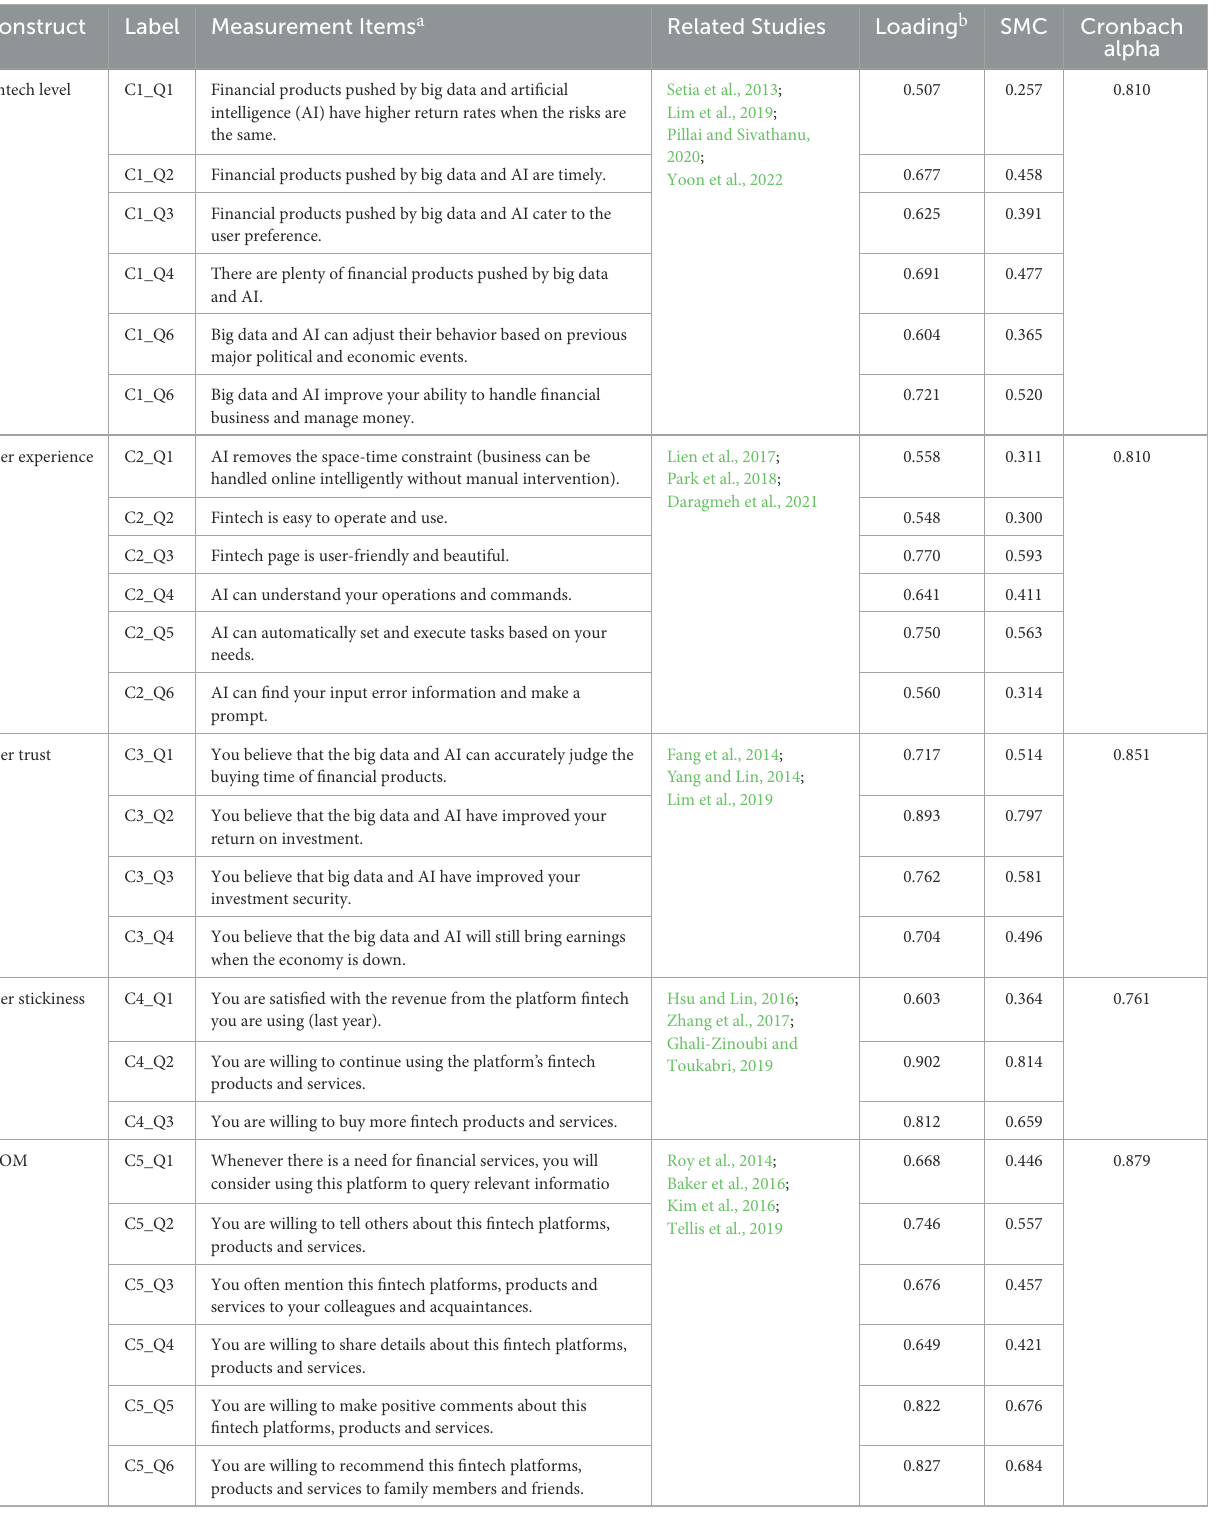
TABLE 2 Main research measurement item